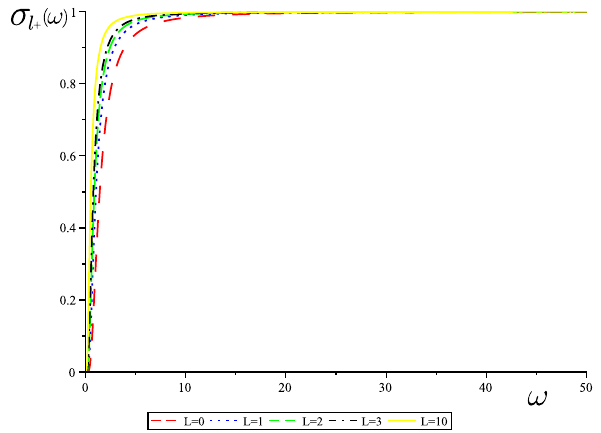
Fig. 5 Plots of σ l + (ω) versus ω for fermions with spin-( + 1 / 2 ). The physicalparametersarechosenas; M = r = 1 , a = 0 . 03and λ = − 1 . 5